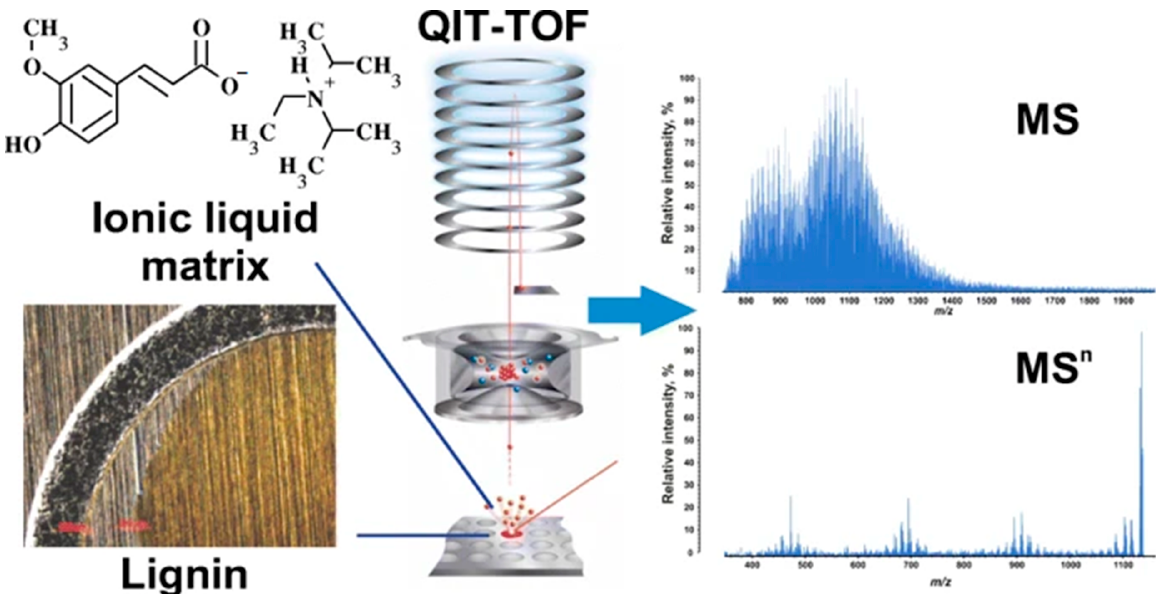
Figure 1. Ionic liquid matrices for matrix-assisted laser desorption/ionization (MALDI) mass spectrometry of lignin produced high-quality MS and MS n mass spectra. Reprinted from Kosyakov et al., with permission from Springer Publishing [40].